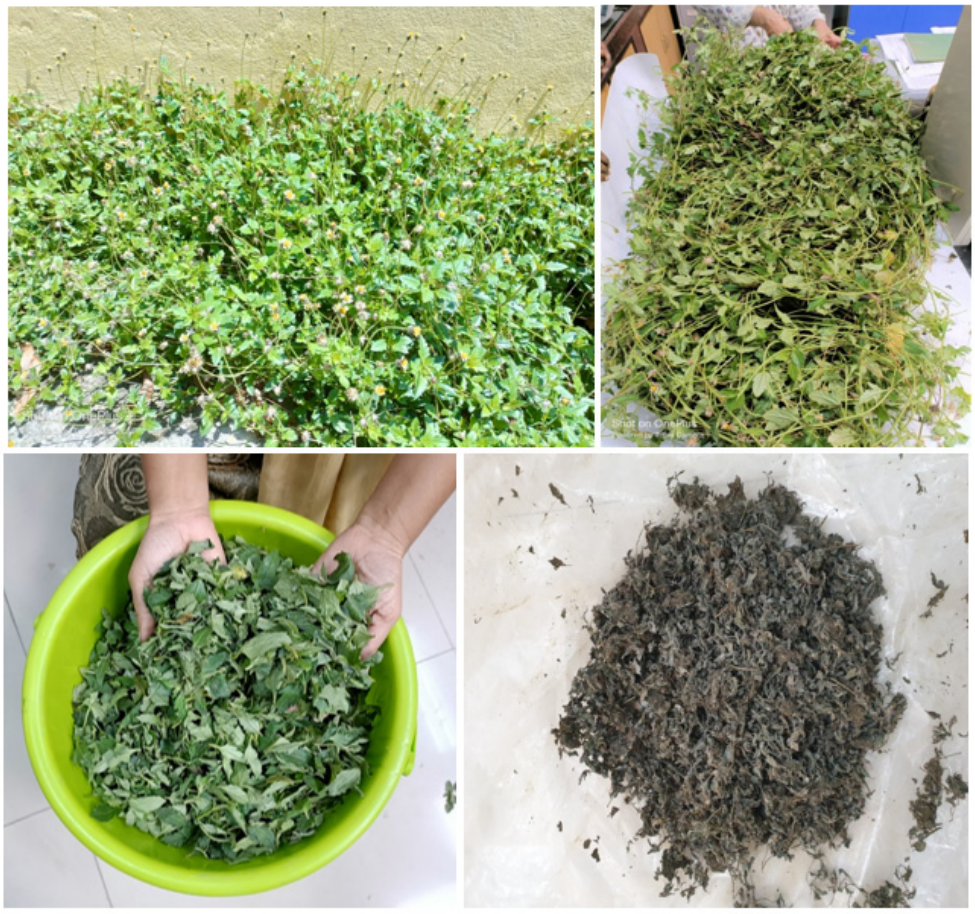
Figure 3. Eclipta alba (Bhringaraj) leaves used in the isolation of methanolic extract were collected from ICAR-CIFRI garden.